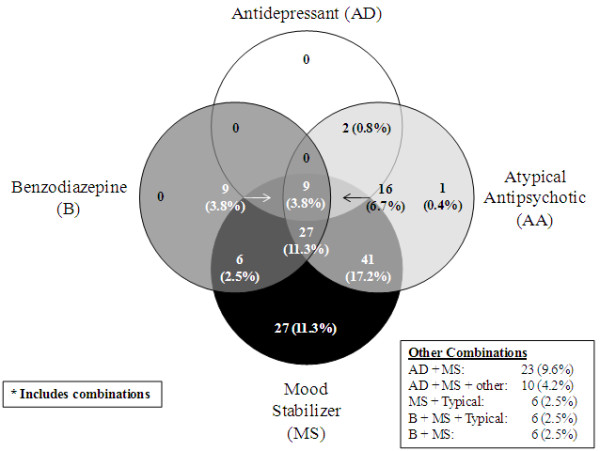
Patterns of Psychotropic Medications1 Taken at First Visit.1 Psychotropic medications included are: atypical antipsychotics (AA), antidepressants (AD), benzodiazepines (B), mood stabilizers (MS; olanzapine, lithium, valporate, and carbemazepine), and other (i.e., anticonvulsants, anticholinergics, anxiolytics, and hypnotics).